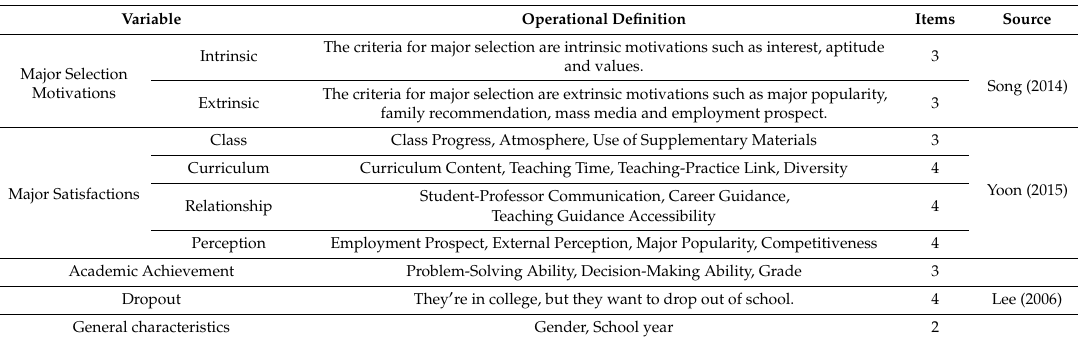
Table 1. Questionnaire Item and Operational